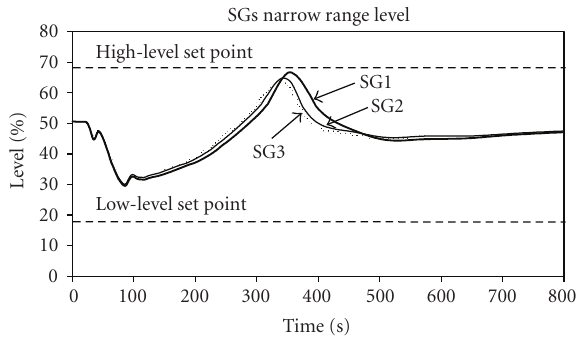
Figure 5: SG3 narrow range level (FW turbo-pump actual tran-